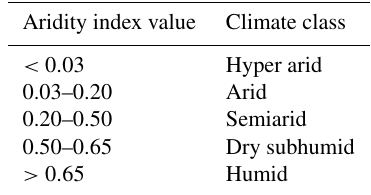
Table 4. Climate classification according to the global aridity index